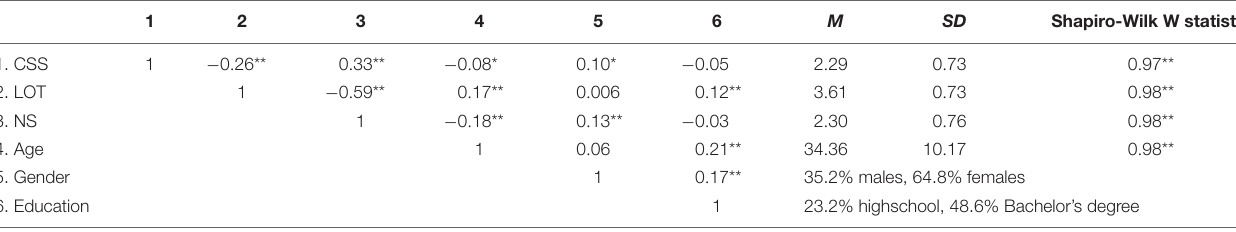
TABLE 1 | Pearson correlations between study variables, means, and standard deviations (N =